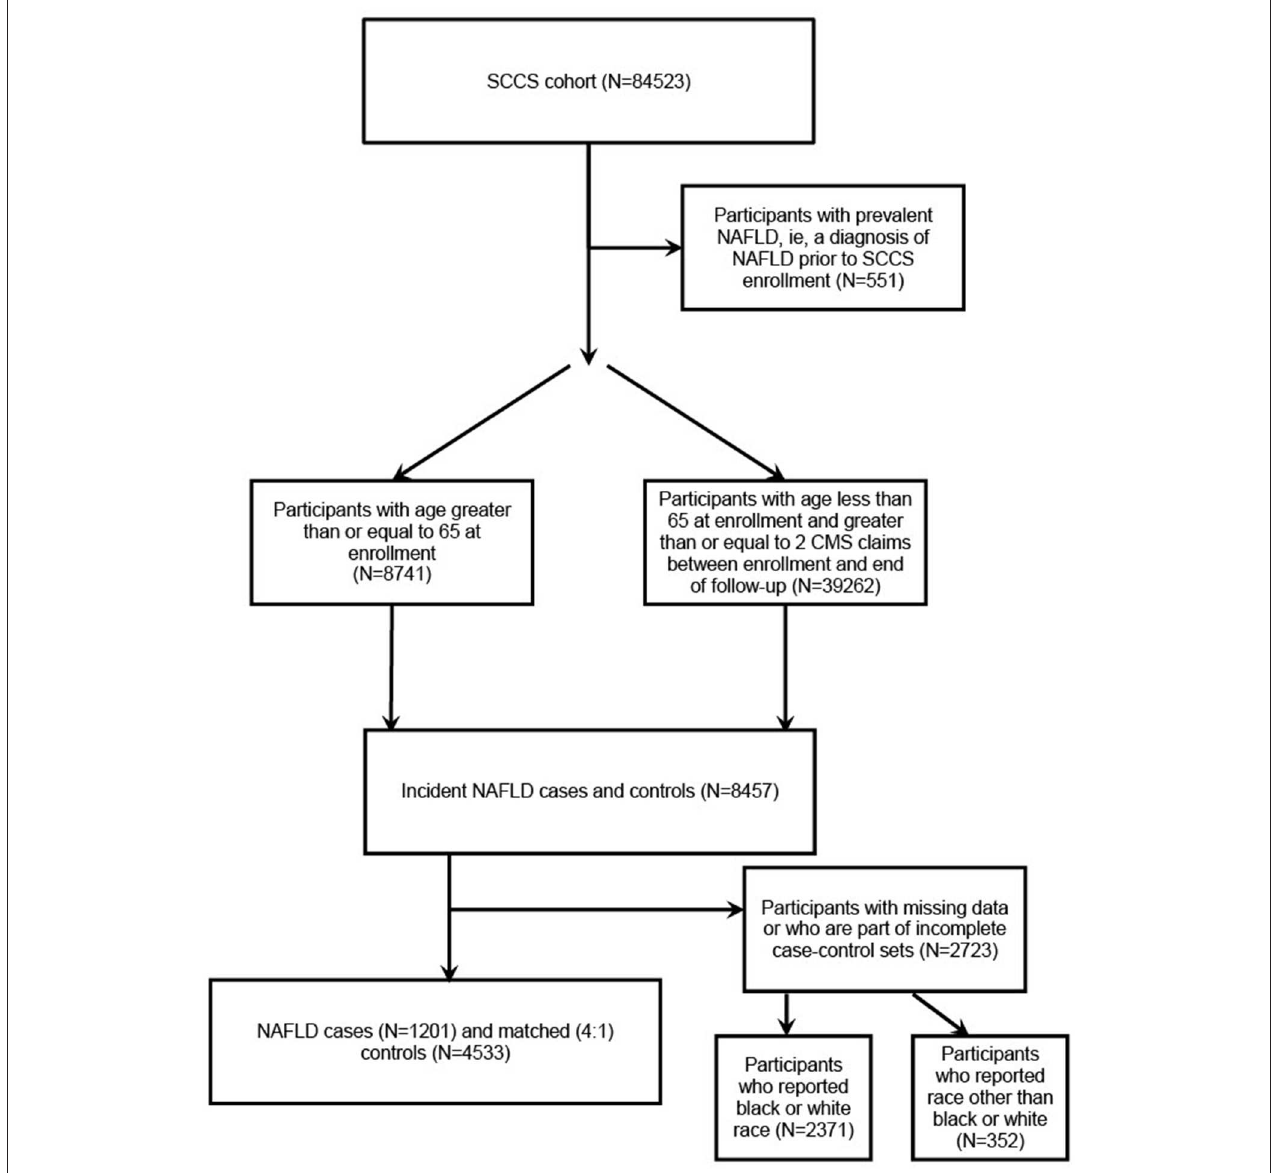
FIGURE 1 | Flowchart of selecting cases and controls from the SCCS